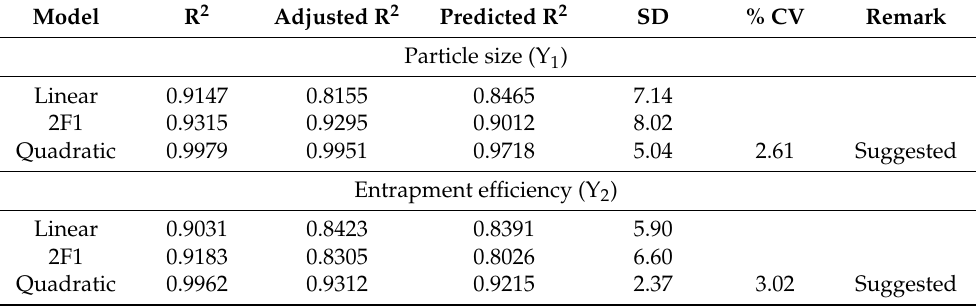
Table 3. Statistical model summary of regression analysis results for response Y 1 , and Y 2.